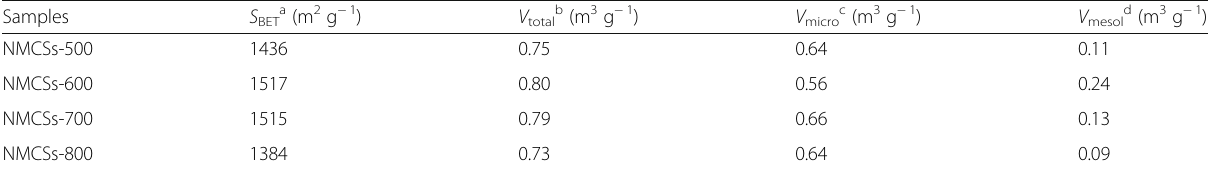
Table 2 Adsorption parameters of NMCSs obtained by analysis of the nitrogen adsorption isotherms and corresponding pore size distributions Samples